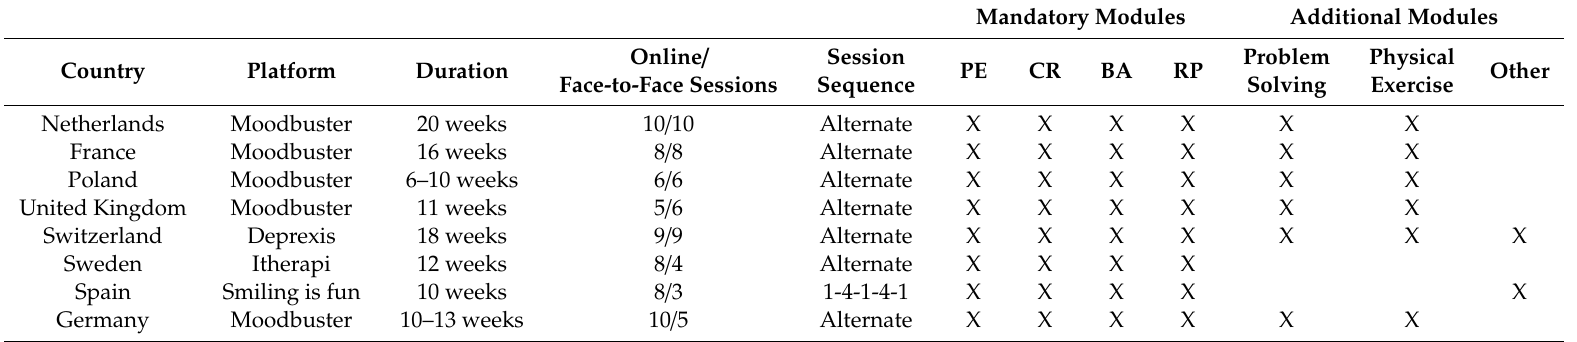
Table 1. Overview of blended treatment applied in each country.